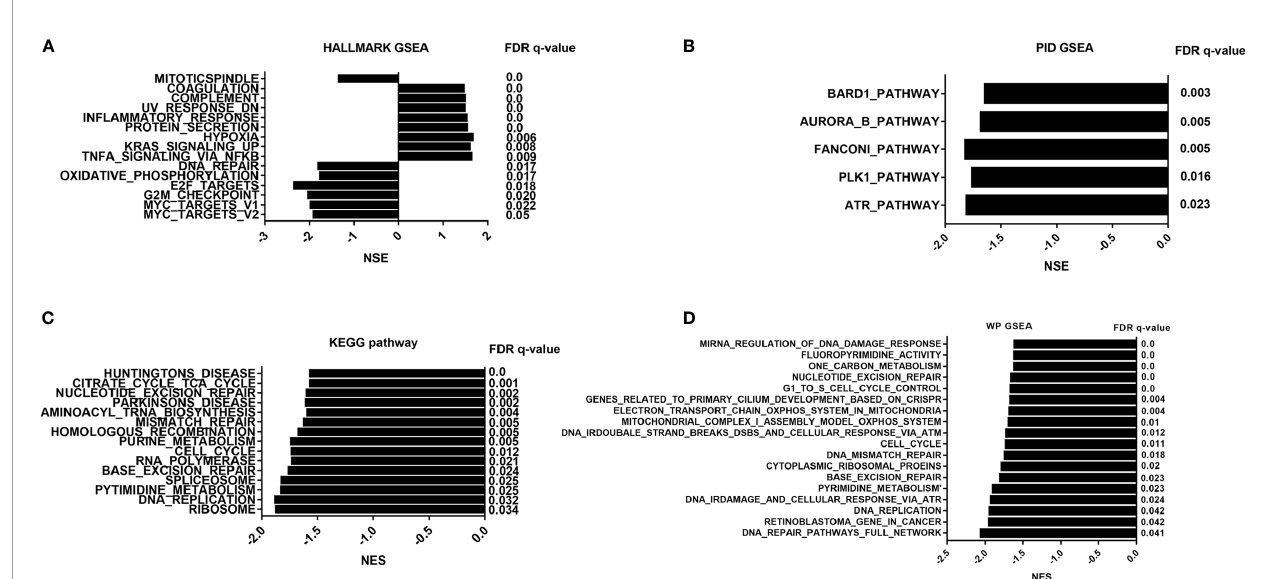
FIGURE 6 | GSEA pathway analysis of B.END3 cells treated with PDT intervention. (A) Hallmark gene set analysis; (B) PID pathway gene set analysis; (C) KEGG pathway gene set analysis; (D) WikiPathways gene set analysis. The threshold value considered as the signi fi cant difference is P < 0.05, FDR q-value < 0.05, and